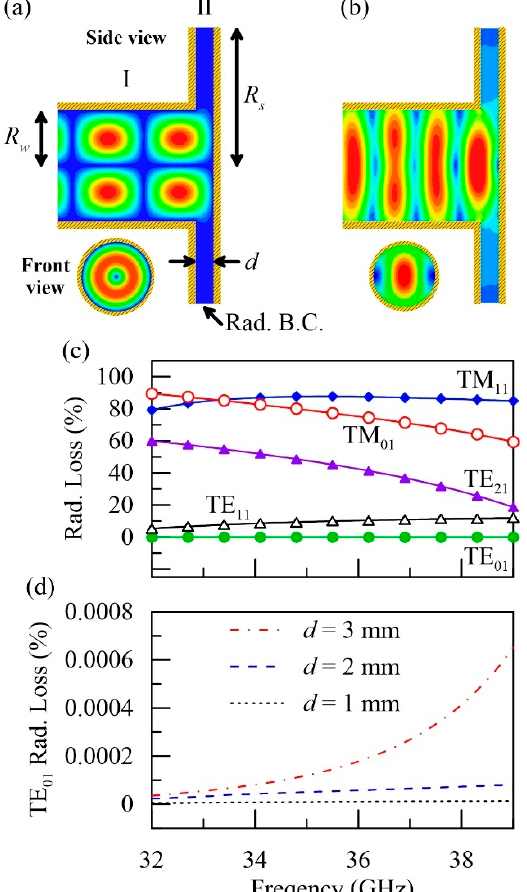
Figure 1. Fringing field patterns of the open-ended circular waveguide probe operated at ( a ) TE 01 mode and ( b ) TE 11 mode. ( c ) Radiation loss versus frequency of the first five circular waveguide modes. ( d ) Radiation loss versus frequency of the TE 01 mode under the three different sample (air) thicknesses.